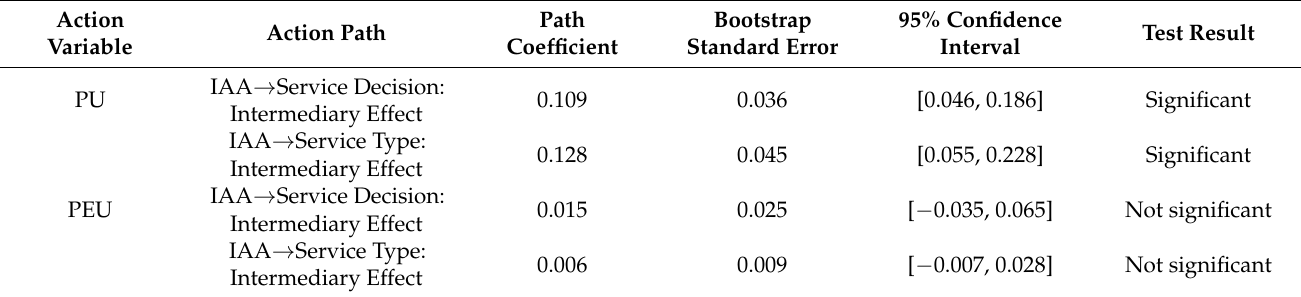
Table 12. Results of the bootstrap-mediated effects